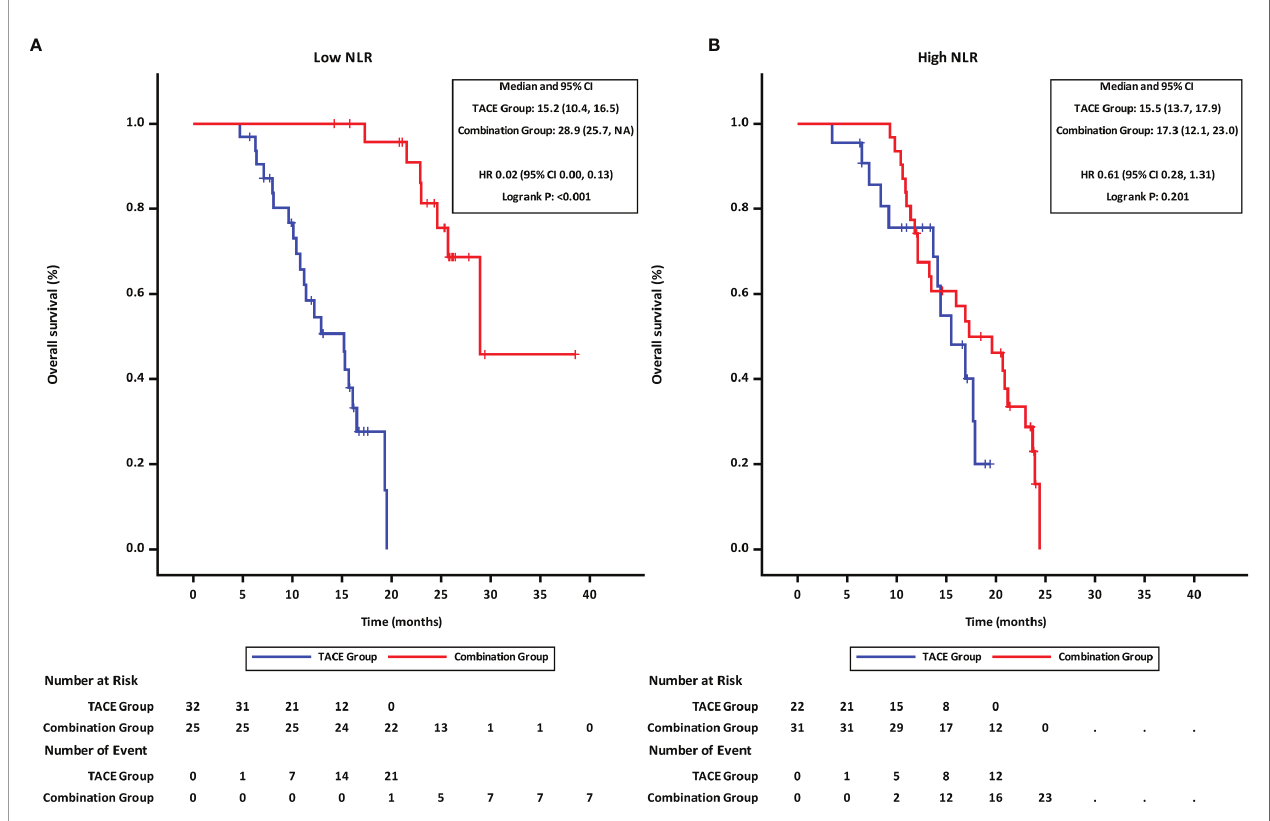
FIGURE 4 | Overall survival of groups of patients with different NLR statuses. (A) low NLR. (B) high NLR. TACE, transcatheter arterial chemoembolization; PD-1, programmed cell death-1; NLR, neutrophil-to-lymphocyte ratio; HR, hazard ratio; CI, con fi dence